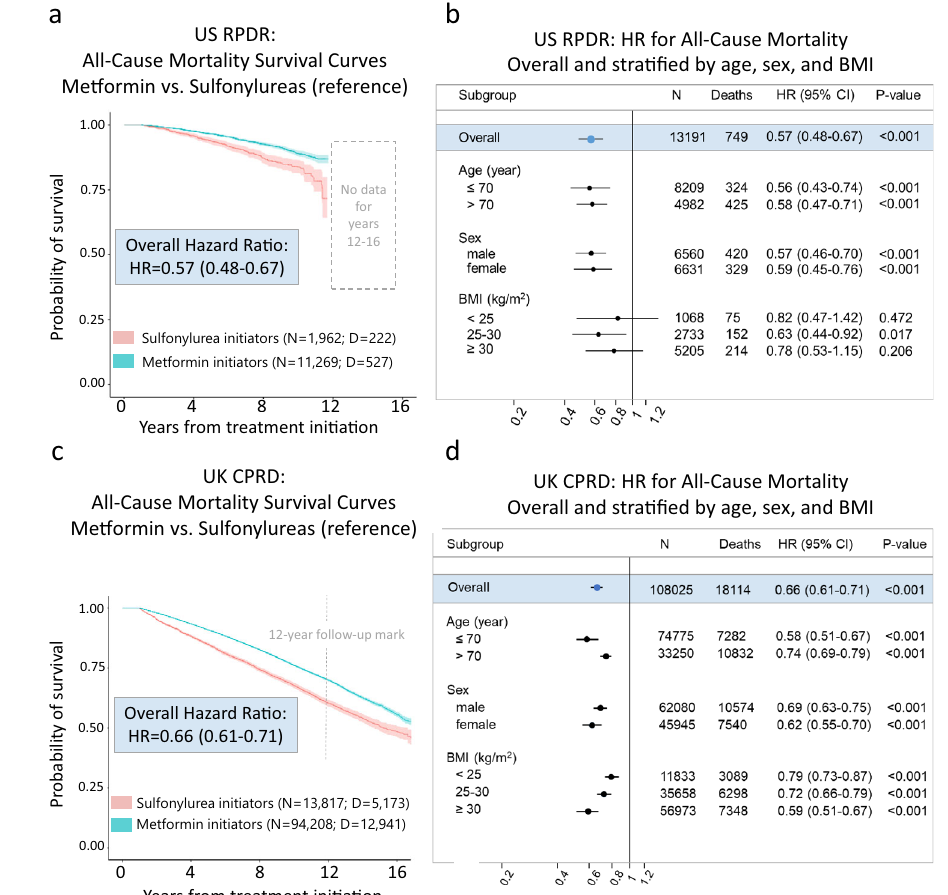
Fig. 2 | Metformin reduces all-cause mortality relative to sulfonylureas among type 2-diabetic patients aged >50 years at treatment initiation. a , c Kaplan – Meier survival curves for metformin and sulfonylurea initiators with shadedareasrepresenting95%Con fi denceIntervals(CI),basedonpointwise0.025- and0.975-quantilesofsamplebootstrapdistributions. N =#ofpatientsatbaseline, D=# of deaths during follow-up. Hazard ratios (HR) were estimated using the Cox Proportional Hazards (PH) model, with only treatment as a covariate, and baseline covariate distributions between treatment arms balanced by Inverse Propensity